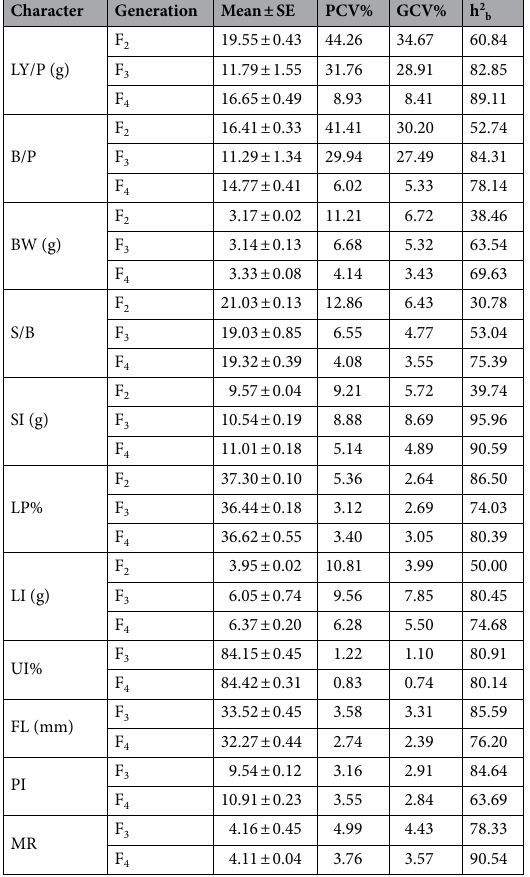
Table 1. Estimates of broad-sense heritability (h 2 b ), phenotypic (PCV), and genotypic (GCV) coefficients of variation, means, and standard errors ( S x ) for the eleven studied characters in F 2 , F 3, and F 4